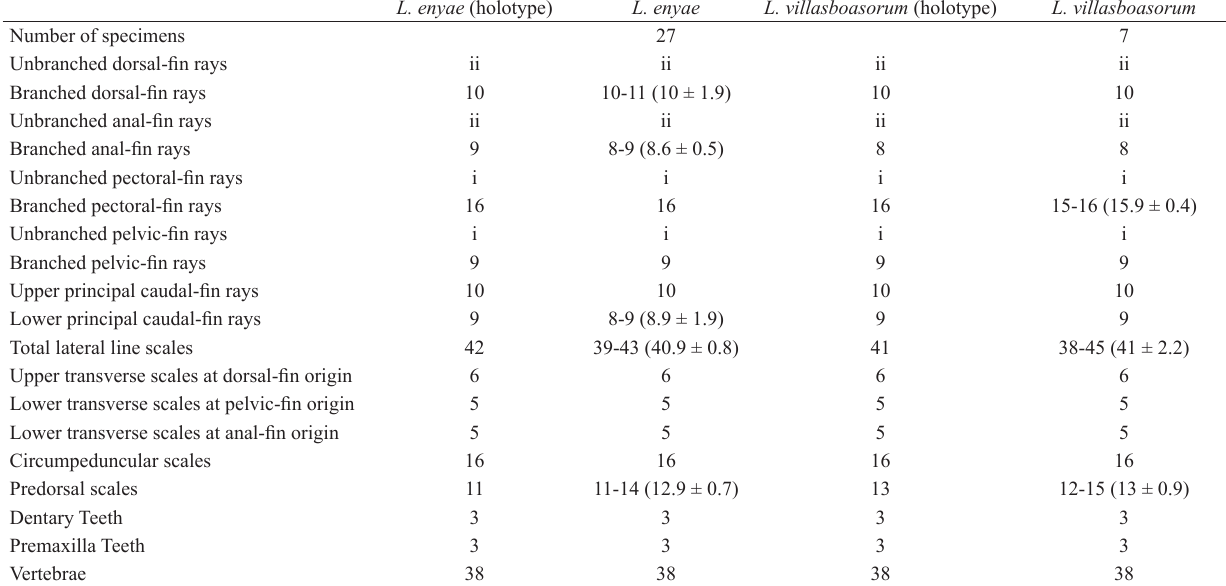
Tab. 3. Meristic counts of Leporinus enyae and L. villasboasorum summarized as ranges followed by the mean ± 1 standard deviation in parentheses. Single values in a cell indicate invariant counts among the examined specimens for a given species.